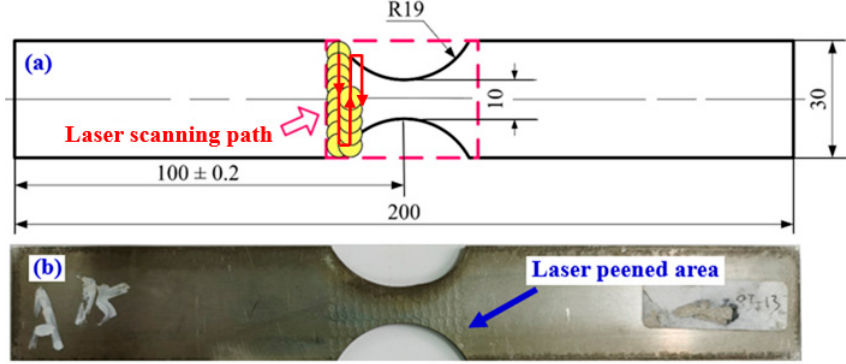
Figure 1. ( a ) Dimensions of fatigue sample and ( b ) LSP sample.